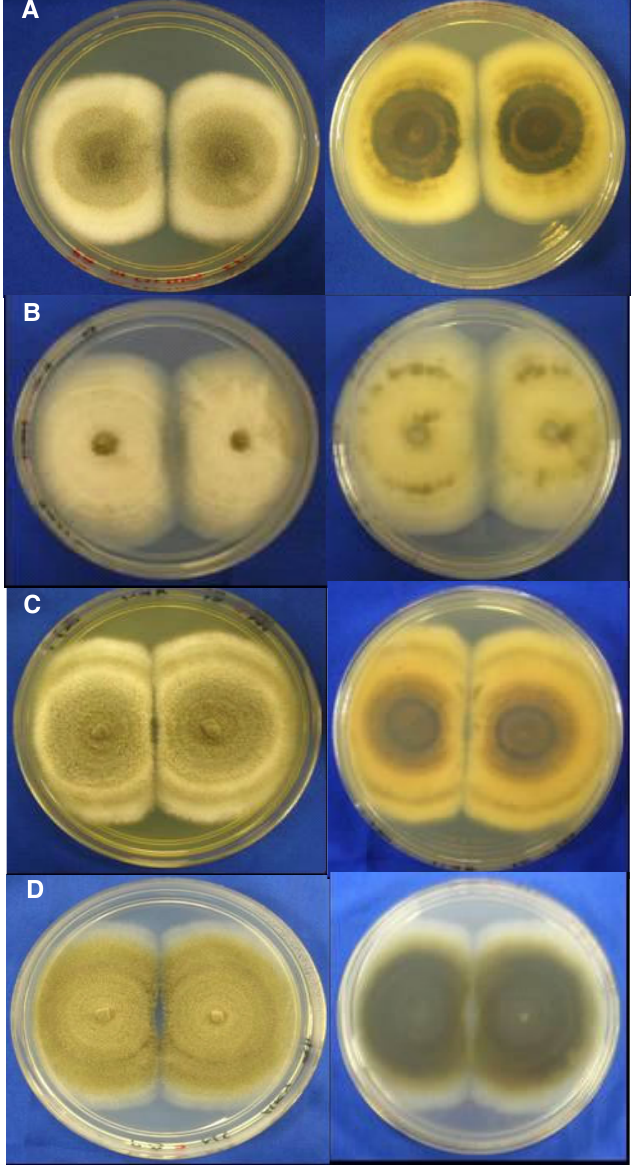
Image 2. Back and front view of different strains of Colletotrichum gloeosporioides on